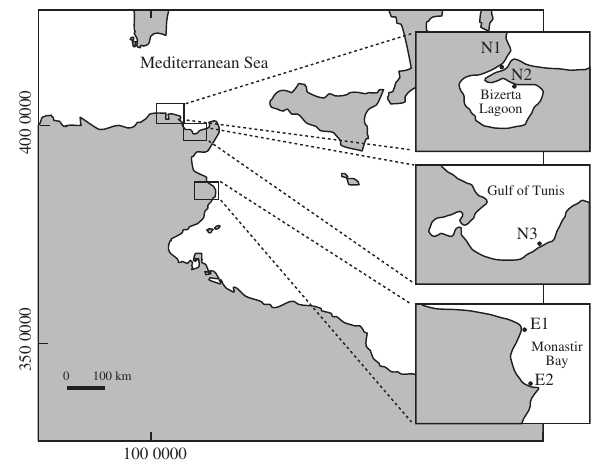
Fig . 1. – the location of the five sampling sites of Pinna nobilis specimens. n1, echaâra; n2, njila; n3, Sidi Rais; e1, Stah Jaber; e2,